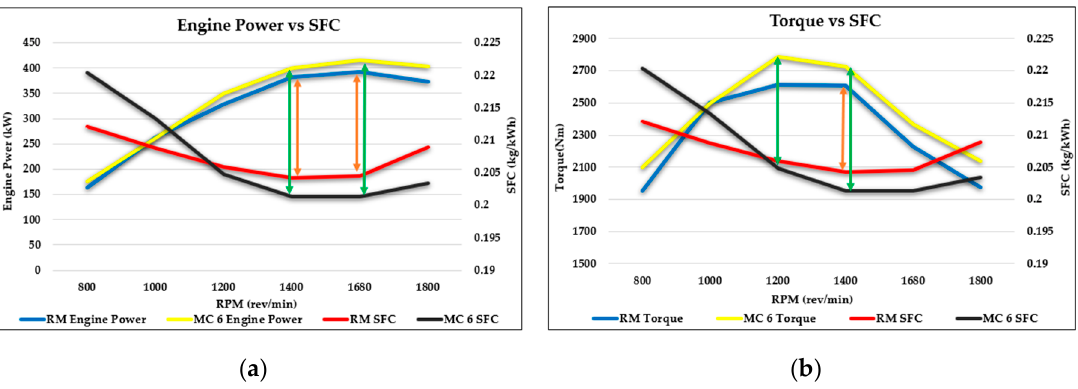
Figure 5. Difference between the performance of the engine and the SFC (kg/kWh) for RM and MC 6. Figure 5. Di ff erence between the performance of the engine and the SFC (kg / kWh) for RM and MC 6. ( a ) Engine power (kW) vs. specific fuel consumption (kg/kWh) and ( b ) torque (Nm) vs. specific fuel ( a ) Engine power (kW) vs. specific fuel consumption (kg / kWh) and ( b ) torque (Nm) vs. specific fuel consumption (kg / consumption (kg/kWh).